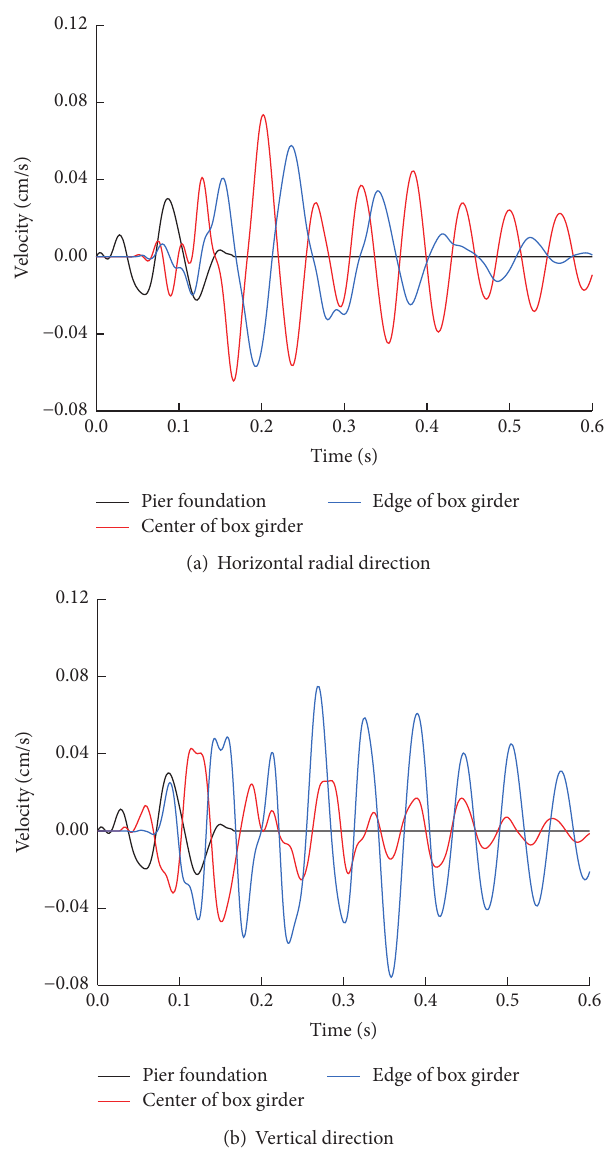
Figure 17: Vibration wave curves of thetypical nodes under theload of 0.03